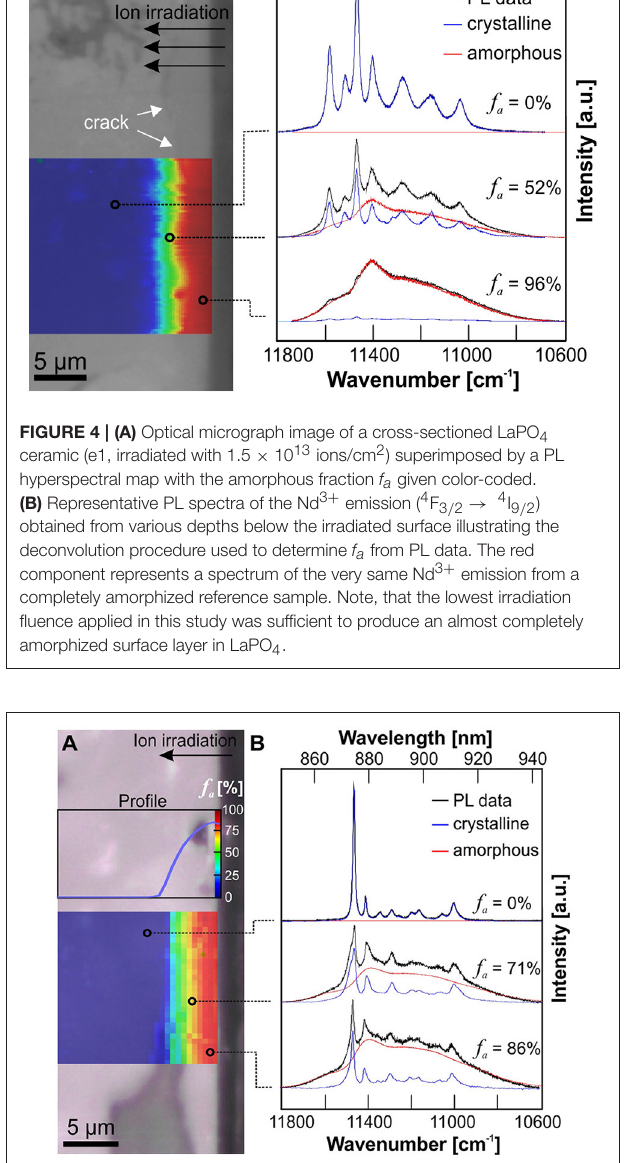
FIGURE 5 | (A) Optical micrograph image of a cross-sectioned YPO 4 ceramic (d5, irradiated with 6.5 × 10 13 ions/cm 2 ) superimposed by a PL hyperspectral map with the amorphous fraction f a given color-coded. (B) Representative PL spectra of the Nd 3 + emission obtained from various depths below the irradiated surface illustrating the deconvolution procedure used to determine f a from PL data. The red component represents a PL spectrum of the very same Nd 3 + emission from a completely amorphized reference sample. The accumulated radiation-damage shows a non-uniform profile with f a decreasing from surface to a depth of ca. 5 µ m.